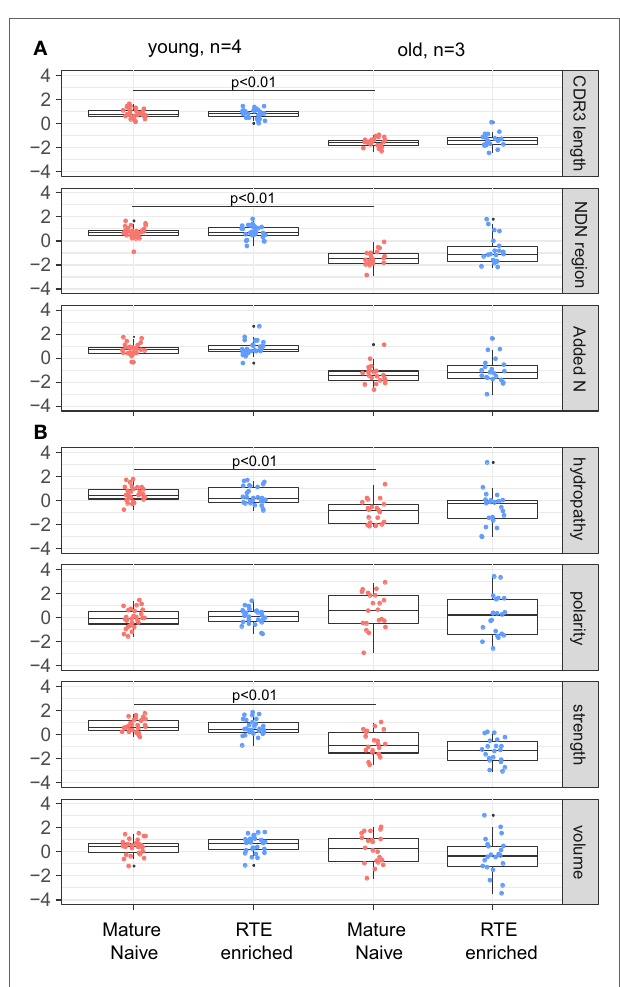
FigUre 5 | T-cell receptor beta CDR3 repertoire properties for mature naïve and recent thymic emigrant (RTE)-enriched CD4 T cells. (a) Average CDR3 length, size of NDN insert, and count of randomly added N nucleotides. (b) Amino acid composition within 5 amino acid residues in the middle of CDR3. CDR3 repertoires for the seven largest TRBV segments were analyzed separately, with Z -score normalization to account for TRBV-specific differences.